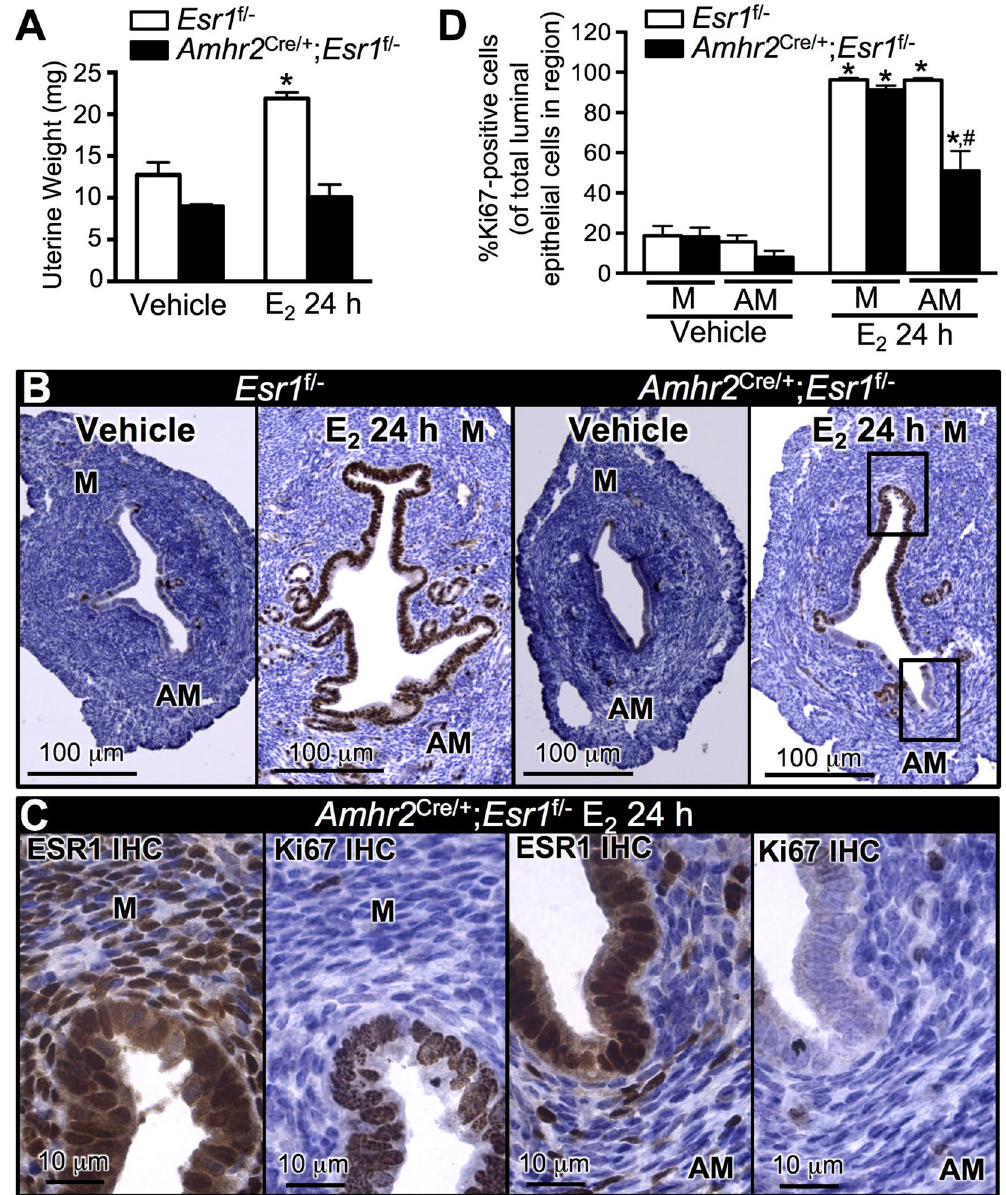
Figure 2. Uterine response to E 2 treatment (24 h) in the absence of anti-mesometrial stromal ESR1. Adult (8–12-week-old) Esr1 f/ − and Amhr2 Cre/ + ; Esr1 f/ − females were ovariectomized and treated with vehicle or E 2 for 24 h. ( A ) Uterine wet weight after 24 h of E 2 treatment. * p < 0.05; significant difference between vehicle and E 2 treated samples within genotype. N = 3 mice/genotype/treatment. ( B ) Uterine epithelial cell proliferation determined by Ki67 IHC staining in Esr1 f/ − and Amhr2 Cre/ + ; Esr1 f/ − uteri. ( C ) Higher magnification of Amhr2 Cre/ + ; Esr1 f/ − treated with E 2 for 24 h. Uterine sections were stained with Ki67 and ESR1 antibodies in adjacent sections. Note that epithelial cell proliferation, as indicated by the appearance of Ki67, is primarily observed in the M where ESR1 is expressed in the adjacent stromal cells. ( D ) Percentage of Ki67-positive cells of total luminal epithelial cells in M vs. AM regions. * p < 0.05; significant difference between vehicle and E 2 treated samples within genotype and region. # p < 0.05; significant difference between Esr1 f/ − and Amhr2 Cre/ + ; Esr1 f/ − uteri after E 2 treatment in the AM region, unpaired t- test. N = 4–8 mice/genotype/treatment. All graphs represent mean ± SEM. M = Mesometrium, AM = Anti-mesometrium. Representative images